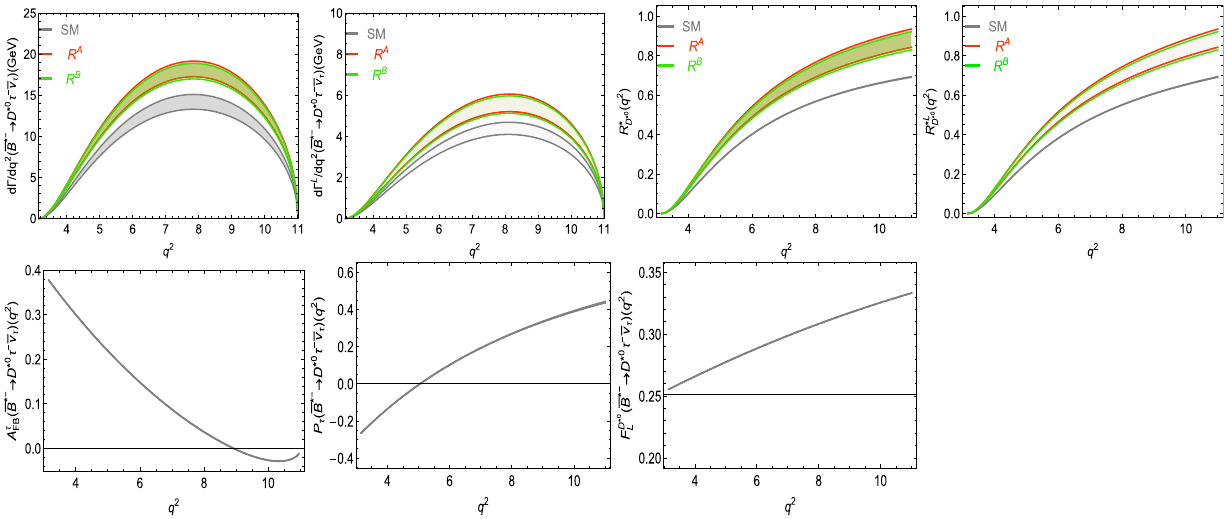
Fig. 6 The q 2 dependence of various observables for the ¯ B ∗− → D ∗ 0 τ − ¯ ν τ decay mode in the SM and vector LQ scenarios. The band widths represent the uncertainties from the decay widths of B ∗ , V cb and NP parameters in the vector LQ